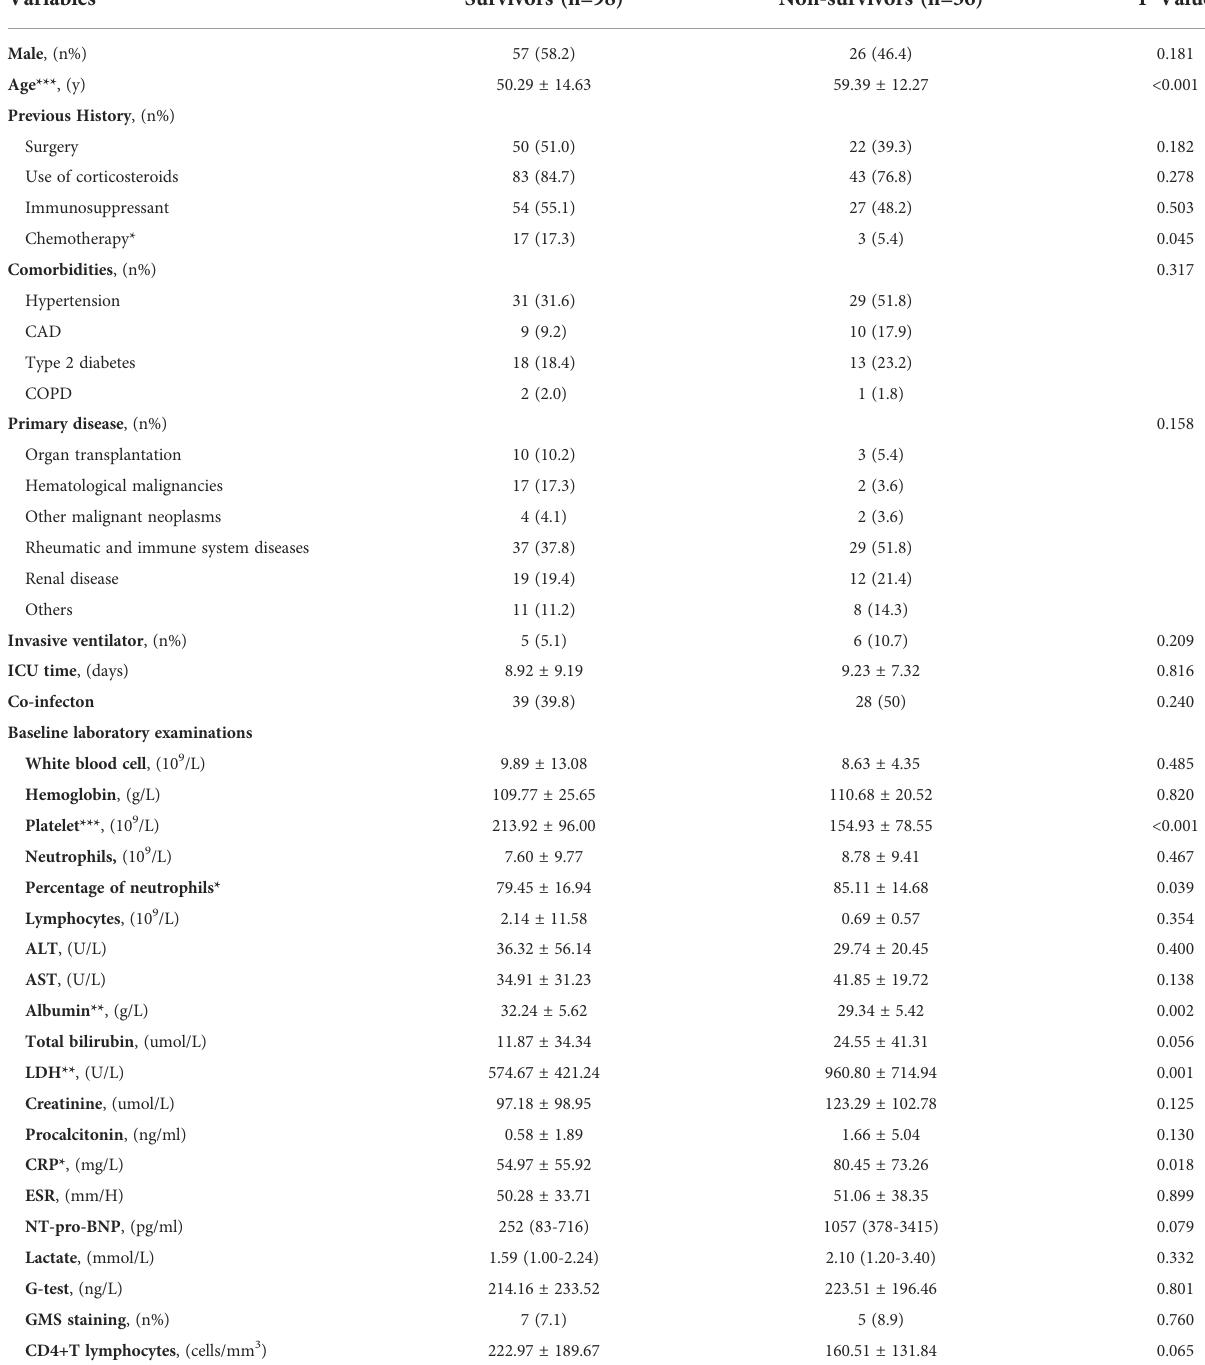
TABLE 1 Baseline characteristics of PCP